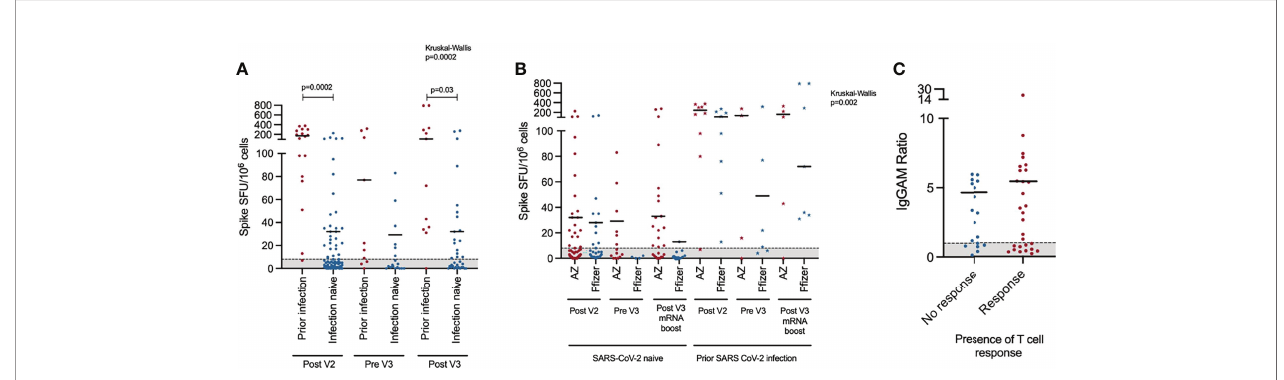
FIGURE 2 | T cell response to third primary immunisation in COV-AD participants: (A) Longitudinal comparison of T cell responses measured using the T-SPOT ® . COVID assay in COV-AD participants by prior infection status. (B) Longitudinal comparison of T cell responses measured using an interferon-gamma release assay in COV-AD participants by initial two-dose vaccine schedule received. Data points represented by stars are individuals with evidence of prior infection. In both cases, the grey shaded area represents the assay cutoff. (C) Comparison of IgGAM ratios of individuals with detectable and undetectable T cell responses.